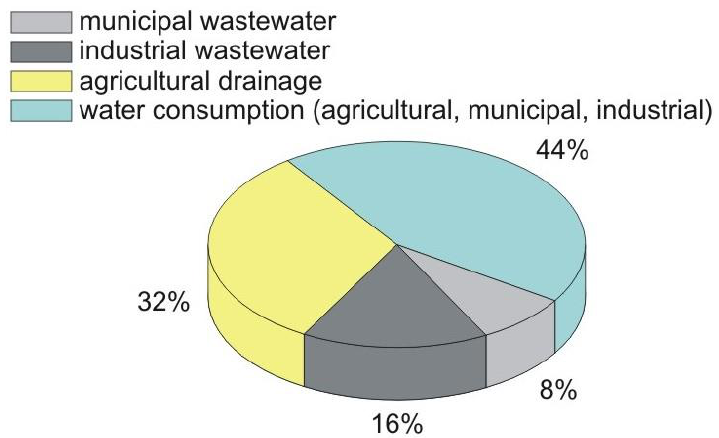
Figure 2. Global water use by sector [28].